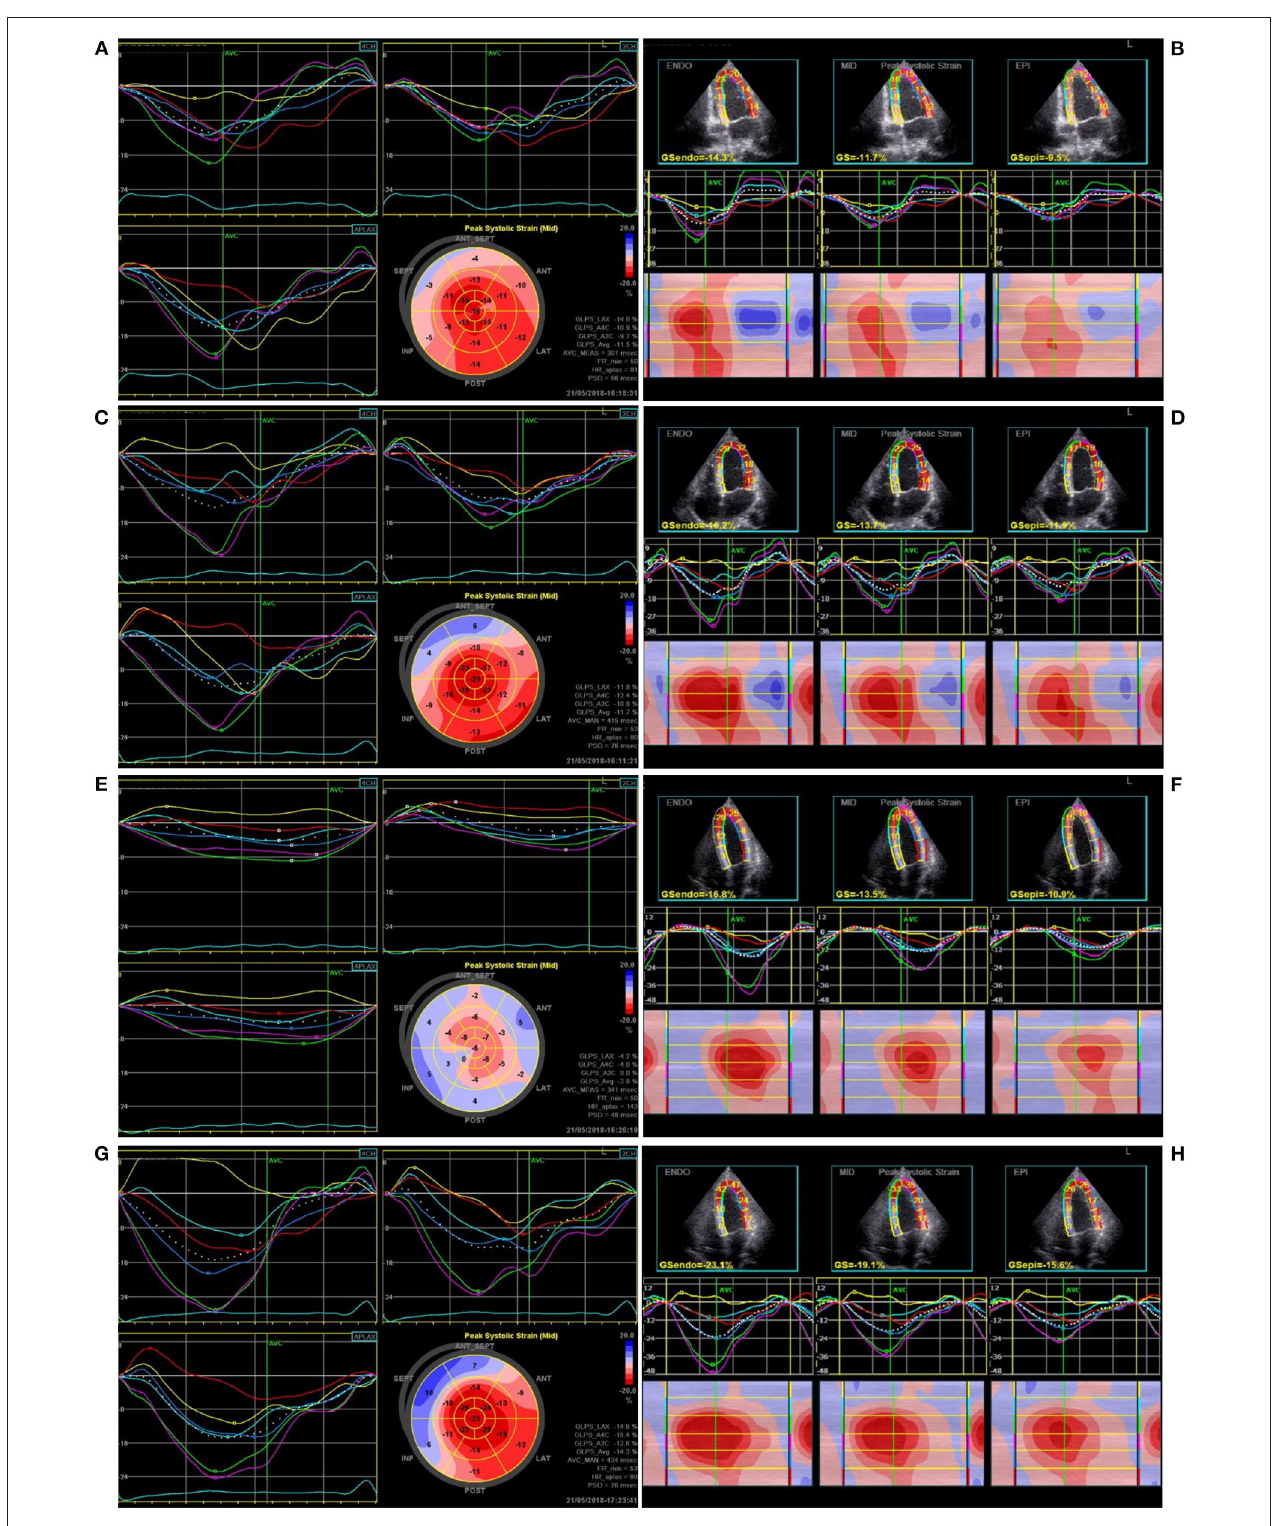
FIGURE 2 | The ventricular global longitudinal peak strain and longitudinal layer-special strain observed in one patient during pacing at different sites. (A,B) Right ventricular apical pacing, (C,D) Right ventricular outflow tract pacing, (E,F) His bundle pacing, (G,H) Left bundle branch pacing.